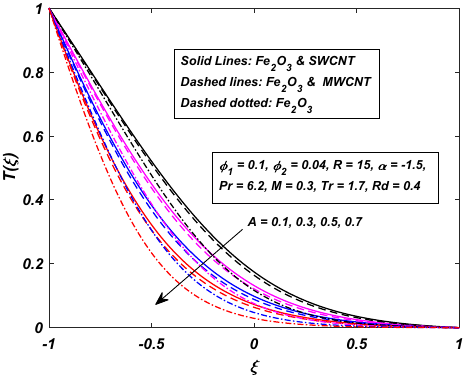
Figure 10. Influence of A on T ( ξ ).